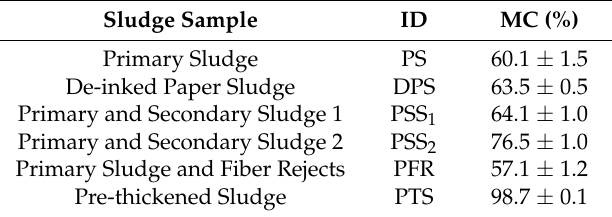
Table 1. Sample nomenclature used throughout manuscript and their respective moisture